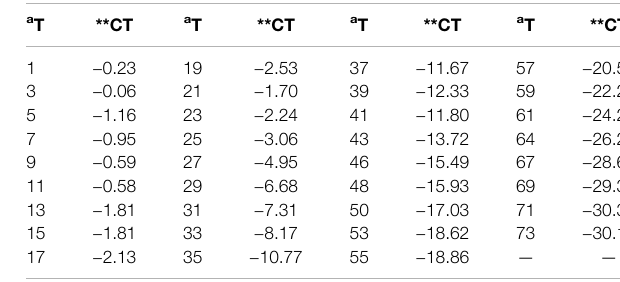
a T, represents the time as the day; **CT; represents the cumulative value in mm.